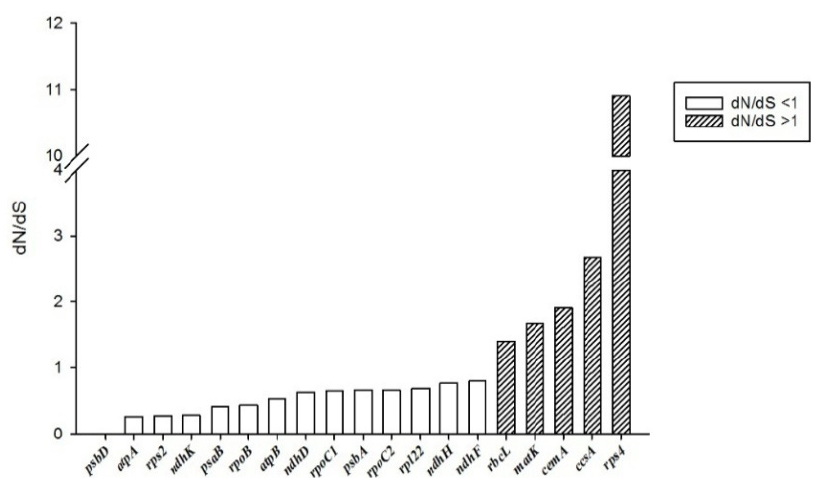
Figure 5. The nonsynonymous (dN)/synonymous (dS) ratio values of 19 genes from six Bambusoi- deae cp genomes ( D. farinosus , Y. brevipaniculata , Ph. edulis , F. edulis , D. bambusoides and B. flexuosa ).